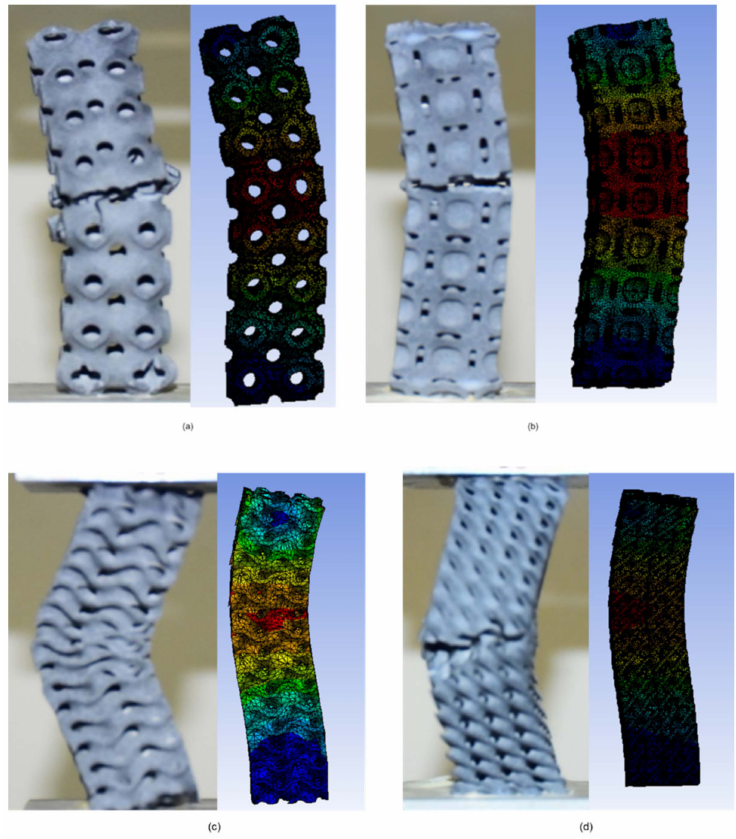
Figure 13. Numerical and experimental patterns of buckling behavior for uniaxial compressive samples of various morphologies. The figures reveal that the experimental and FEA results show good agreement. Samples with 2 × 2 × 8 configuration: ( a ) Schwarz-P, ( b ) Neovius, ( c ) Gyroid and ( d ) Diamond.